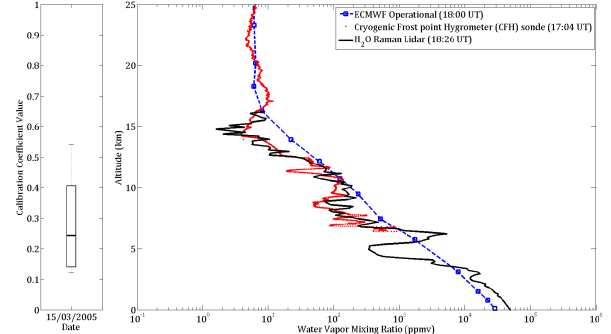
Fig. 3. Intercomparison between H 2 O Raman lidar (black line), Figure 3. Intercomparison between H 2 O Raman lidar (black line), Cryogenic Frost point 3 Cryogenic Frost point Hygrometer (CFH) sonde (red dots) and Hygrometer (CFH) sonde (red dots) and ECMWF operational analysis (blue line) on 15 4 ECMWF operational analysis (blue line) on 15 March 2005. The March 2005. The calibration coefficient and his error are shown on the left. Calibration has 5 calibration coefficient and its error are shown on the left. Calibra- been realized using ECMWF Operational data before comparison with CFH. 6 tion has been realised using ECMWF Operational data before com- parison with CFH.